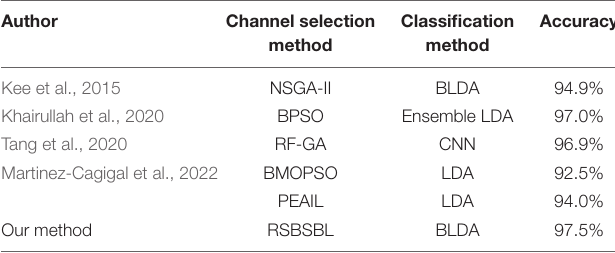
TABLE 3 | Character recognition accuracy (%) of comparison with state-of-the-art results (DS2).